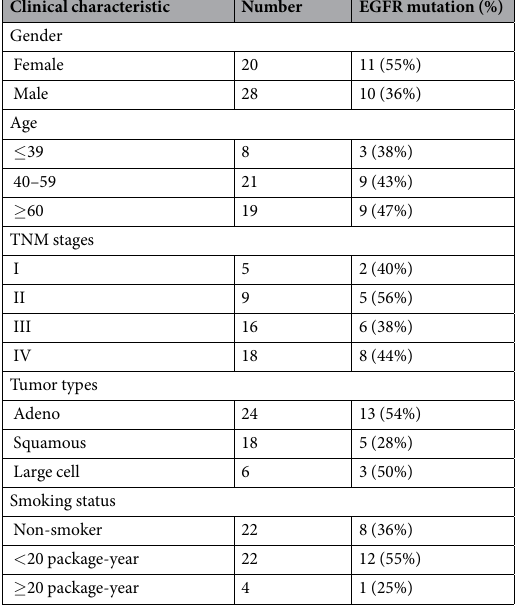
Table 4. Frequency of EGFR mutation in relation to clinical characteristics of NSCLC patients.